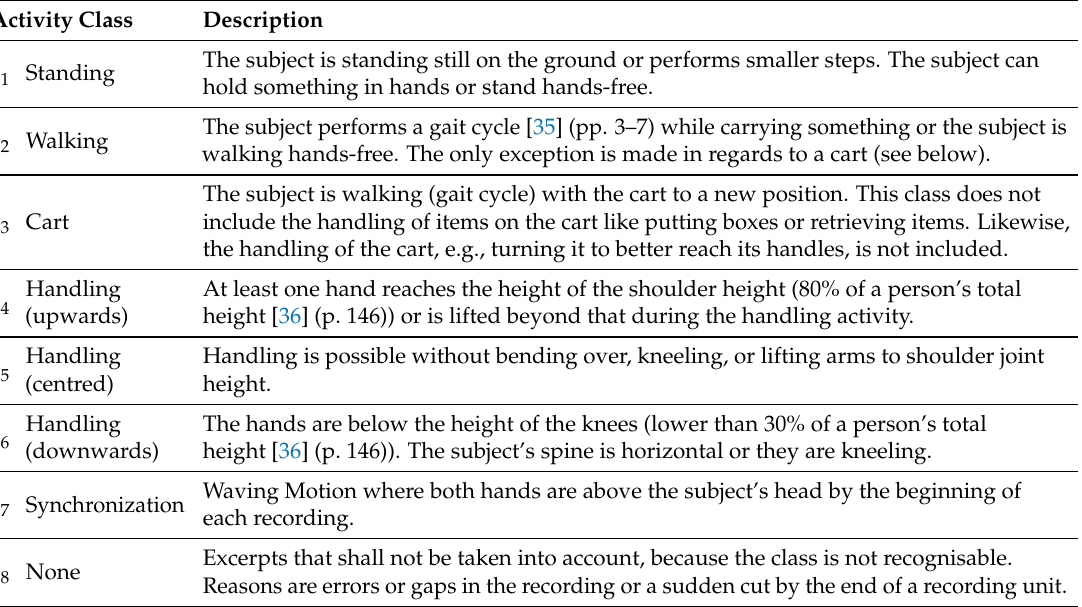
Table 2. Activity Classes and their semantic